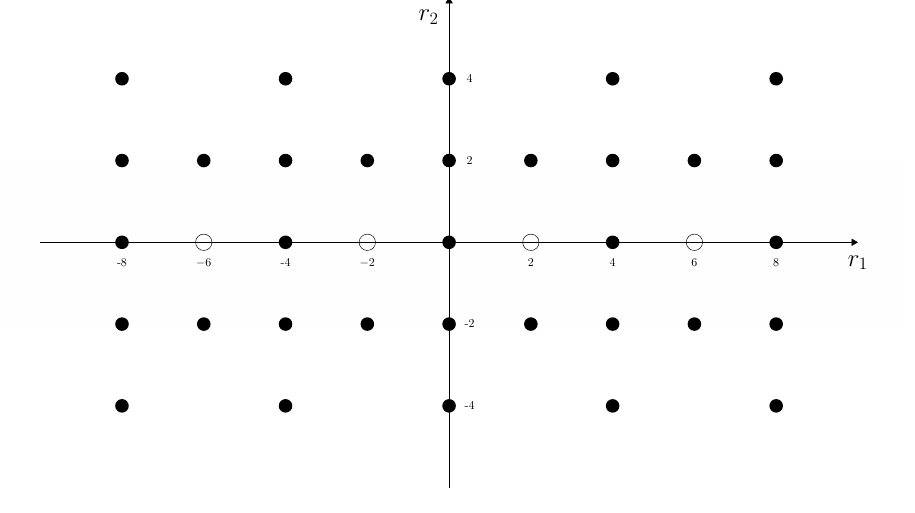
Figure 4 . The r lattice of local F